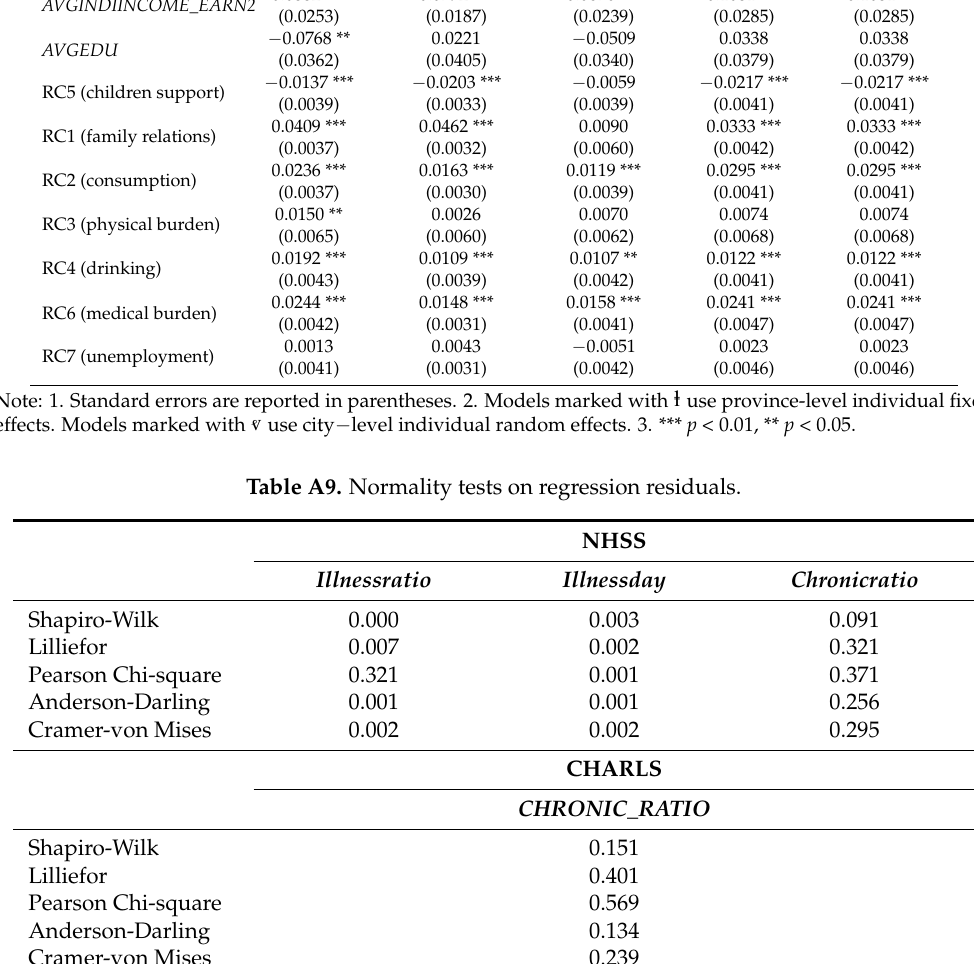
Table 4. Results of the regression analysis on NHSS dataset.